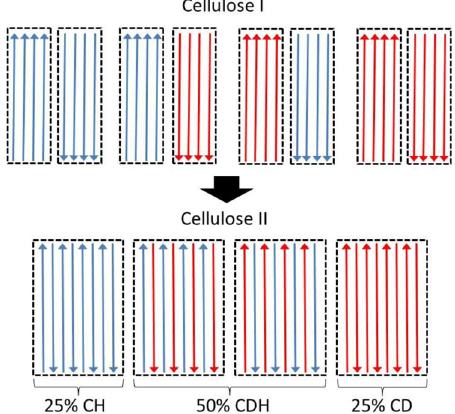
Fig. 3 | Schematic representation of how diffracted neutron intensities from CDH-cellulose II were calculated based on the model ofKolpak and Blackwell. We represent the case when conversion to cellulose II occurs only when chains move between neighboring cellulose I nanocrystals with opposite polarity. Indivi- dualnanocrystalsincelluloseI,orcrystallinedomainsincelluloseII,areoutlinedby broken black lines. Within crystalline domains, hydrogenous and deuterated cel- lulose chains are represented in blue and red, respectively. The chain direction is represented by anarrow. The top half of the diagram represents the four different possible interactions between hydrogenous and deuterated nanocrystals with oppositepolarity.Thereareequal(50:50)amountsofhydrogenousanddeuterated nanocrystals randomly distributed within cellulose I samples and with random up or down orientations with respect to the fi ber axis. After mercerization, 50% of crystalline domains will contain equal amounts of hydrogenous and deuterated chains, 25% will contain just hydrogenous chains, and 25% will contain just deut- erated chains. KB-calculated-neighbor is obtained from the sum of these con- tributions.Thesizeoftheunitcellsfor25%CHand25%CDandtheaveragedcellfor 50%CDHisthesame.Therefore,thepositionofintensitiesinthediffractionpattern from asample containing mixtures of these different unit cells would coincide.We do not expect additional re fl ections.